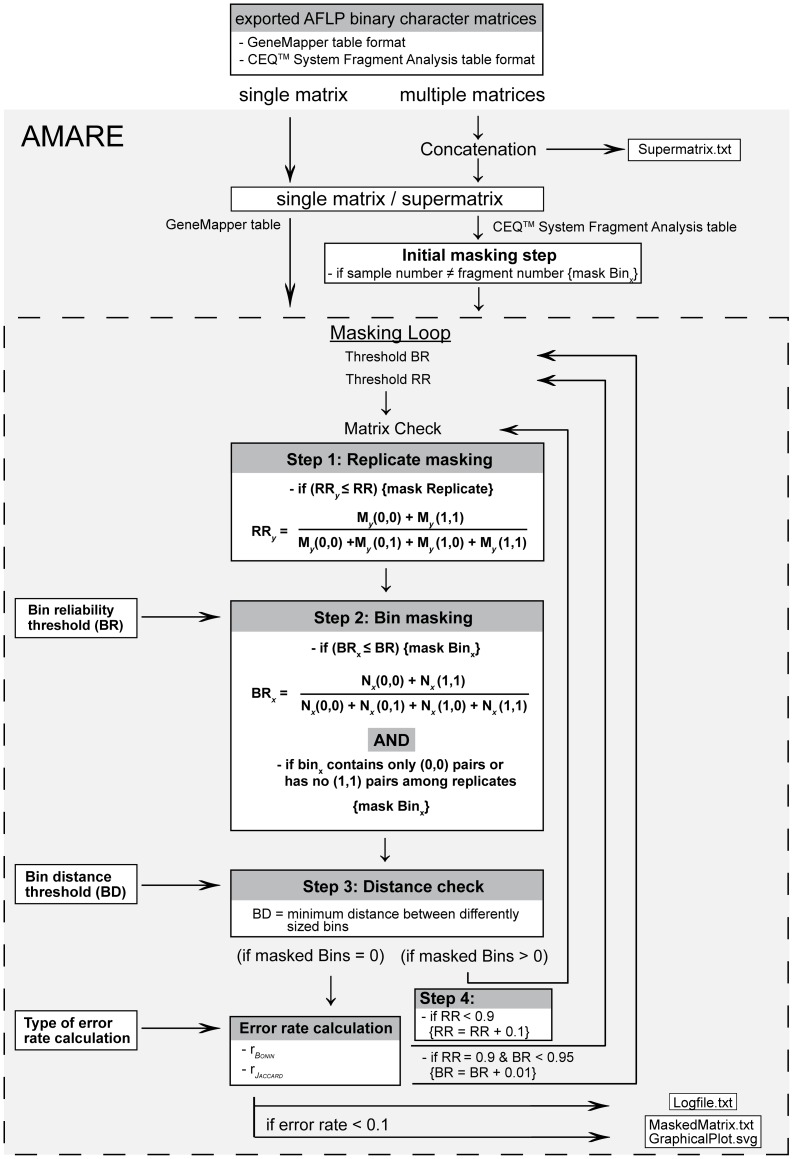
Flow chart of AMARE.